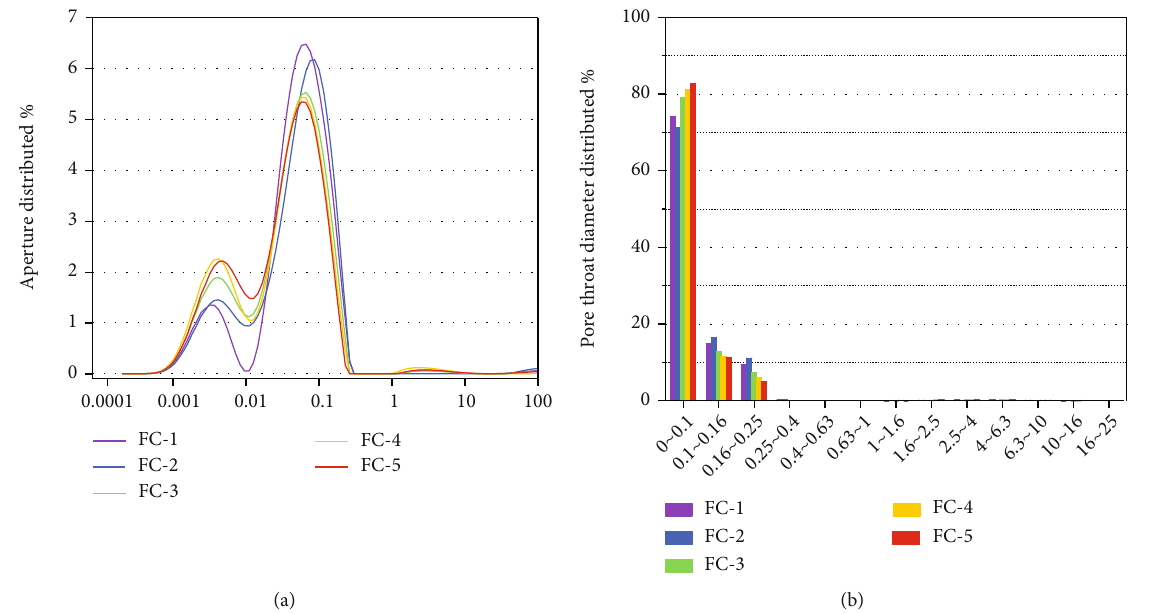
Figure 3: Distribution of pore size and pore throats. (a) Schematic diagram of shale aperture distribution/ μ m. (b) Pore throat diameter/ μ m